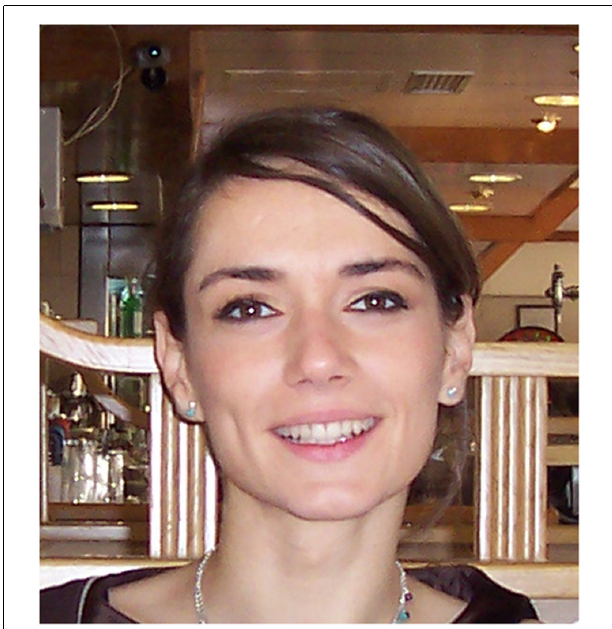
FIGURE 9 | Gunvor Kullberg, reproduced from Hariz et al. (2014). Using the 133Xe inhalation method she studied cerebral blood flow after stereotactic lesioning in psychiatric and Parkinson’s patients (Kullberg and Risberg, 1978, 1985). She demonstrated a decrease in cerebral blood flow in the prefrontal cortex following capsulotomy and frontobasal tractotomy and argued that this could indicate a lower prefrontal neural activity as a consequence of disruption in the neural pathways (Kullberg and Risberg, 1985). She also studied the evolution of stereotactic lesions using the CT scan and showed that corticosteroids could reduce the size of the surrounding edema (Kullberg et al., 1980; Cronqvist and Kullberg, 1983). Dr. Kullberg retired in the early 1990s and currently lives in